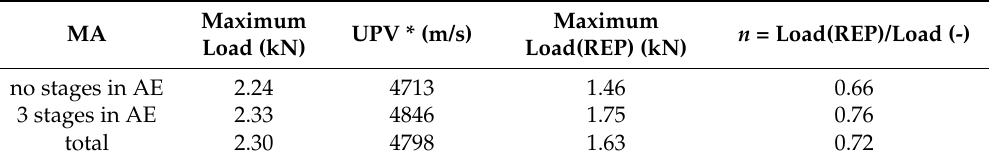
Table 3. Results of the bending tests for MA type of repaired marble.